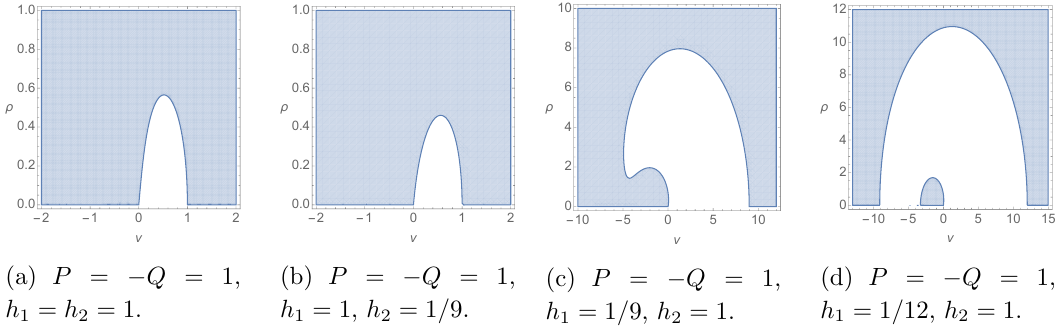
Figure 8. Examples of the curve e 2(cid:6) 2 = 0 for di(cid:11)erent values of ~ P and ~ Q with QP < 0. di(cid:11)erently from Brill’s solution, the NUT parameter ~ J is not an additional parameter, but rather an e(cid:11)ective parameter that is expressed in terms of the electric-magnetic